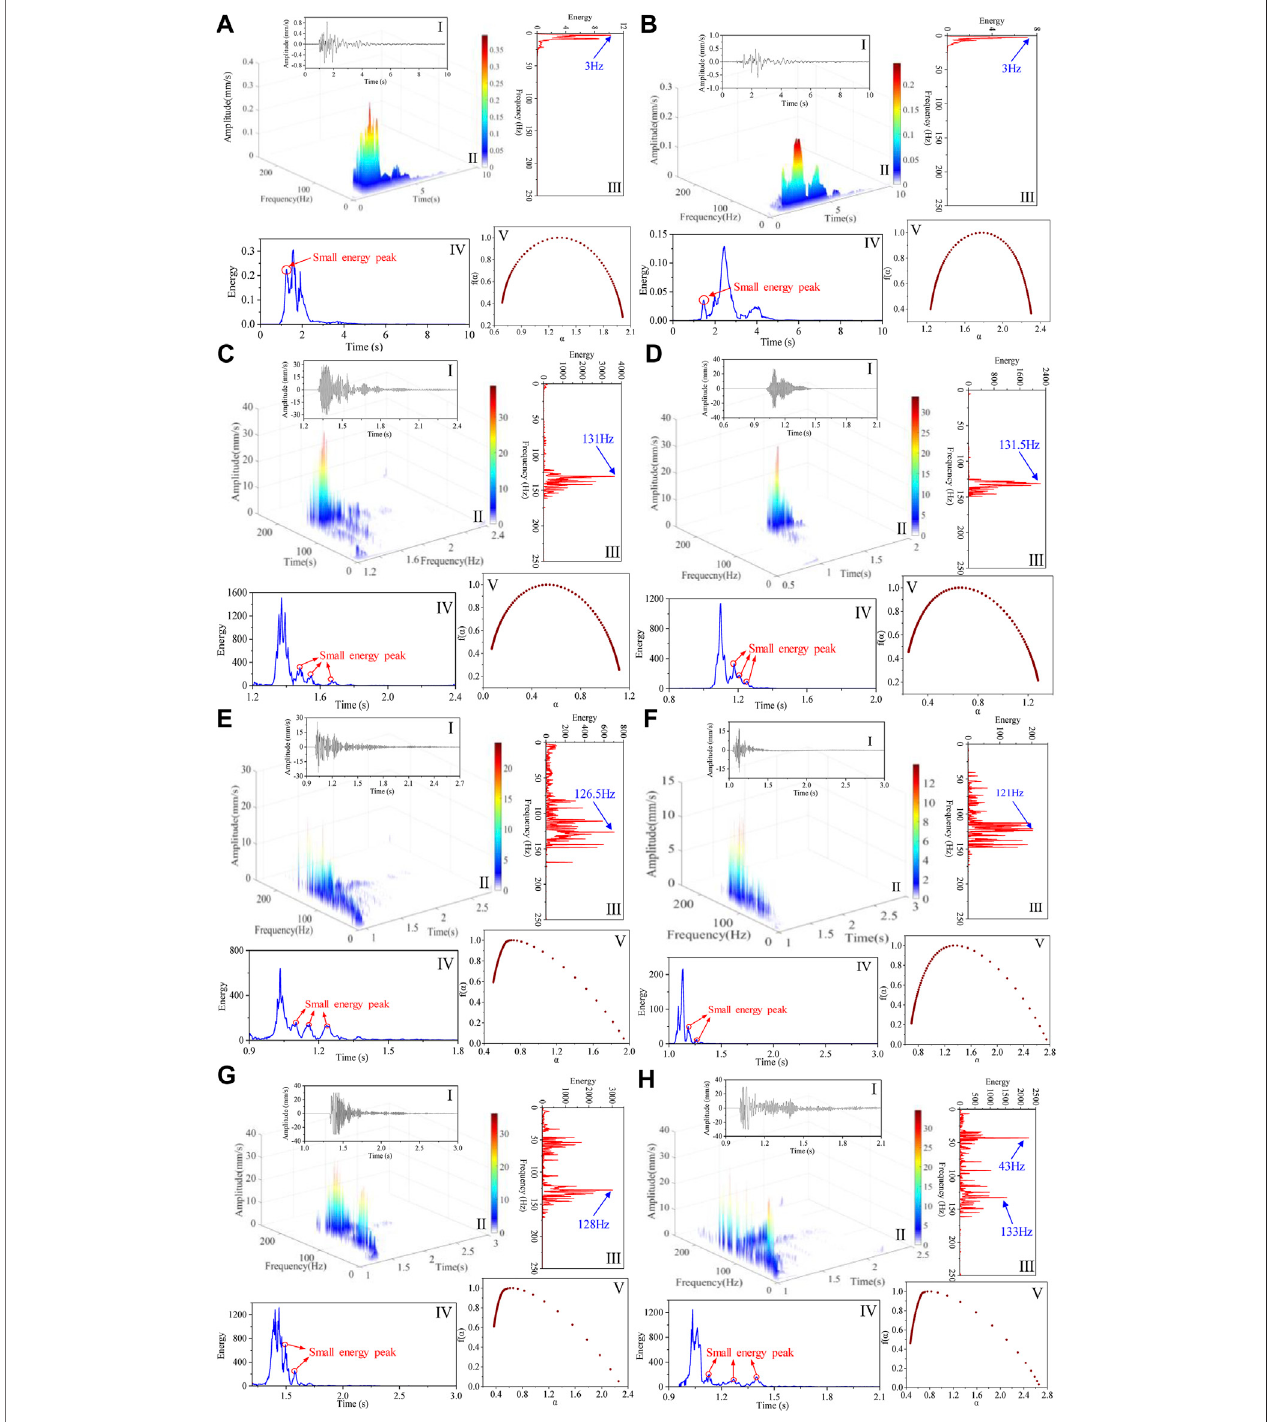
FIGURE5| Hilbertspectrumandmultifractalspectra f( α )- α ofdifferentinducedmicroseismicwaveforms (A) GB-M-1; (B) GB-M-2; (C) M-M-1; (D) M-M-2; (E) DB- M-1; (F) DB-M-2; (G) DB-M-3; and (H) DB-M-4.